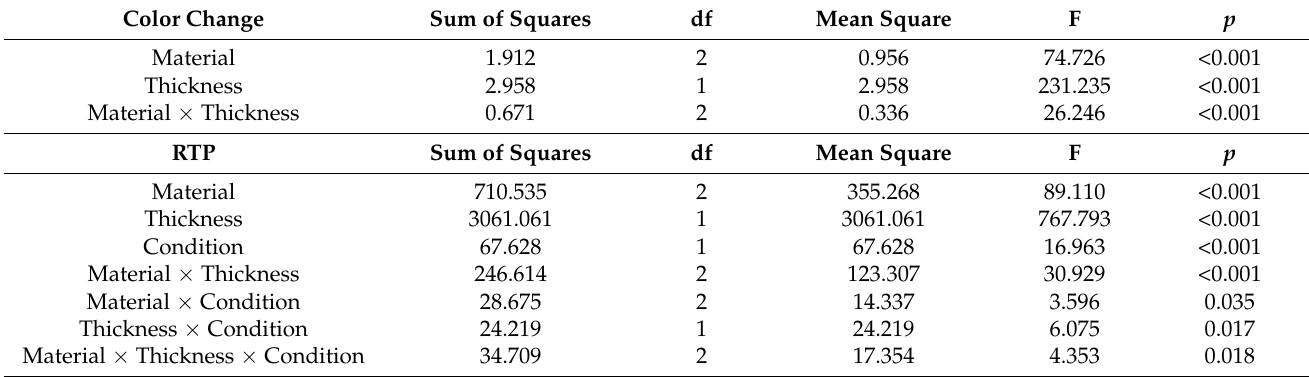
Table 3. ANOVA results of the color parameters.